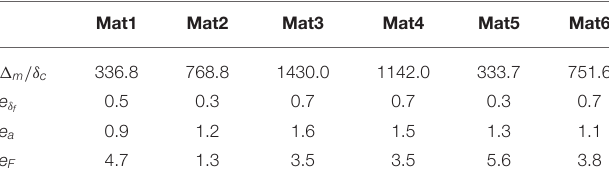
TABLE 2 | Maximum normalized deformation and mean absolute